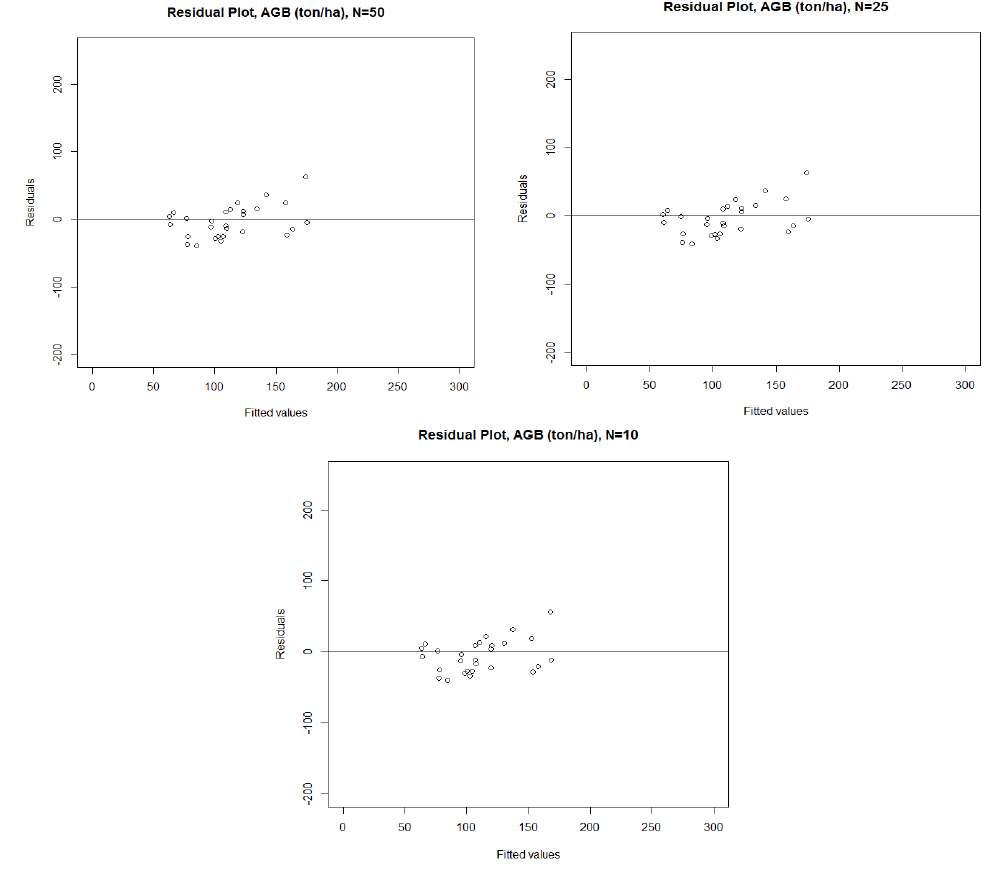
Figure 7. The residual plots of RapidEye for AGB at validation